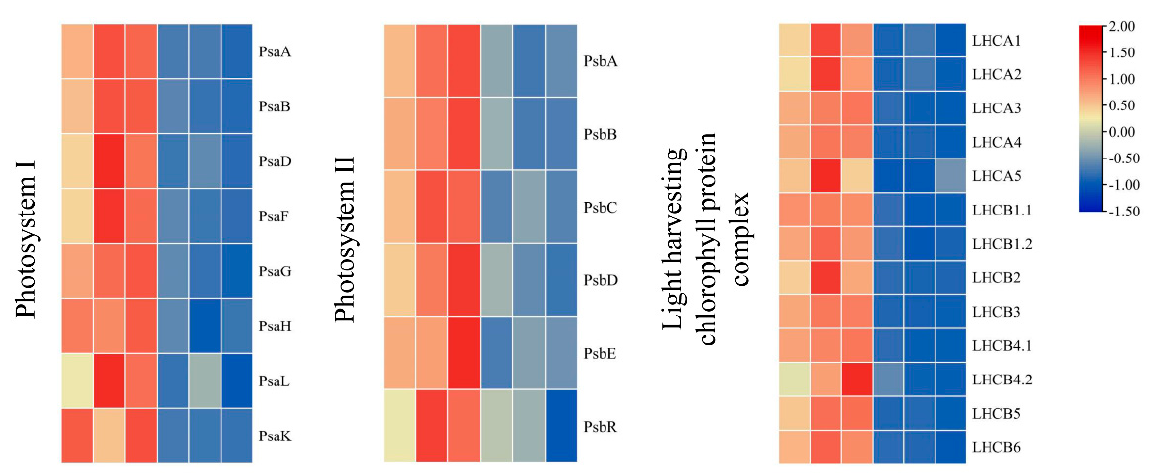
Figure 6. The differentially accumulated proteins associated with photosynthesis in green and mutant leaves. Identified DAPs are shown using a heatmap. Green leaves-1, G-1; Green leaves-2, G-2; Green leaves-3, G-3; Mutant leaves-1, M-1; Mutant leaves-2, M-2; and Mutant leaves-3, M-3 (left to right: G-1, G-2, G-3, M-1, M-2 and M-3).